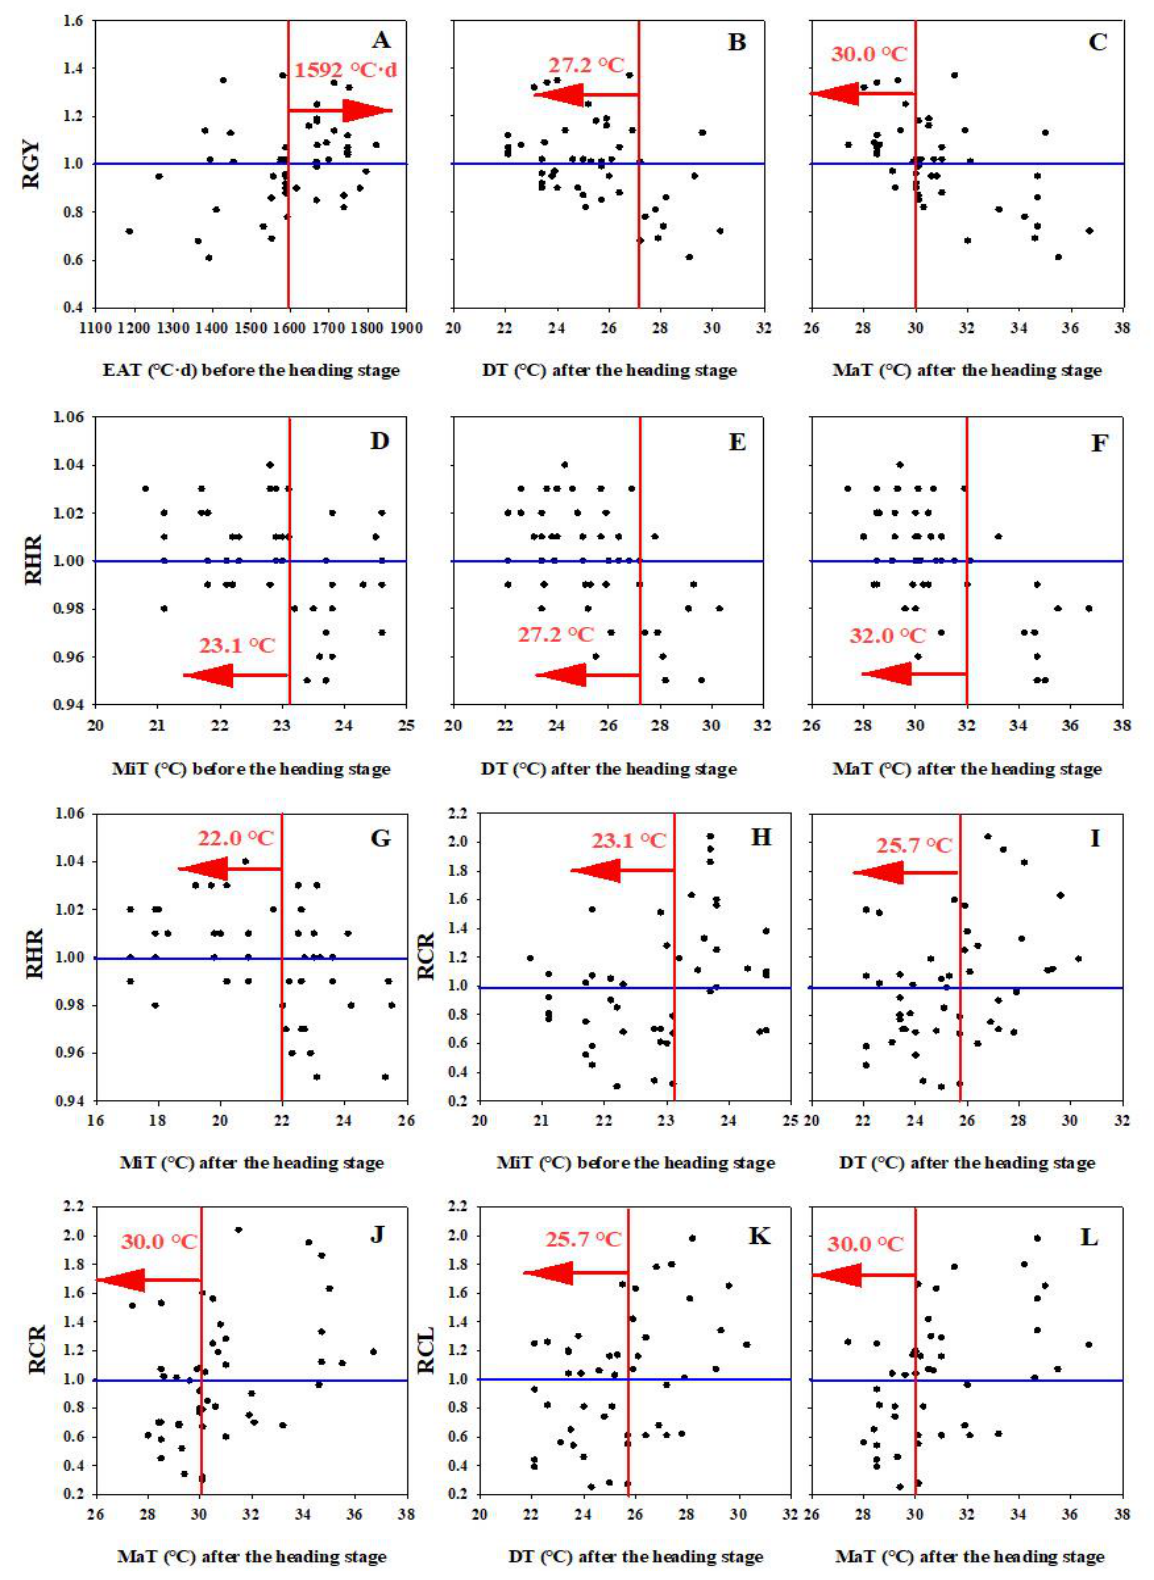
Figure 5. Grain yield ( A – C ), head rice rate ( D – G ), chalky grain rate ( H – J ) and chalkiness level ( K , L ) trends with temperature condition. The blue line represents temperatures for RGY, RHR, RCR and RCL at 1.0. The red line is the temperature threshold dividing line.